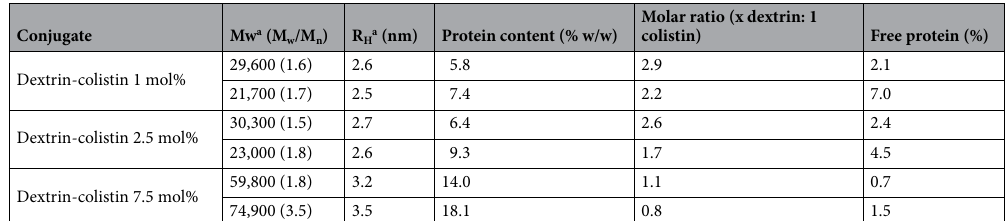
Table 2. Characteristics of dextrin-colistin conjugates used in these studies. a measured using Viscotek TDA 302 detector with 2 × Ultrahydrogel 250